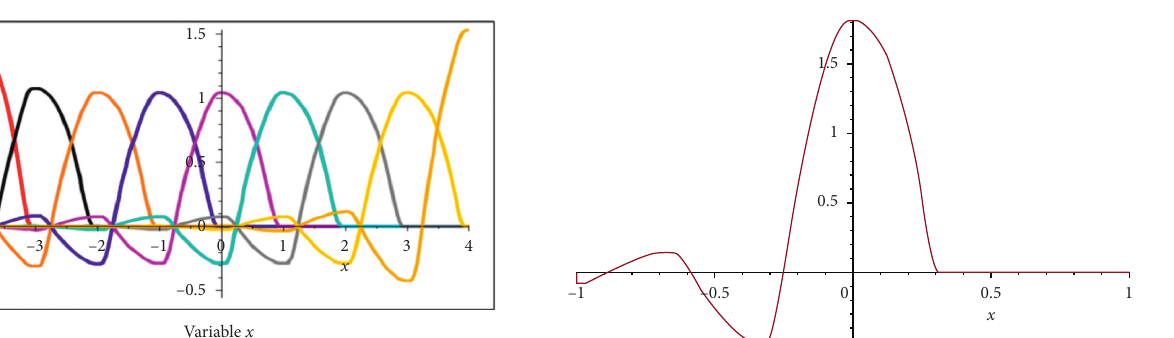
Figure 2: Illustration of orthonormal family ( Ψ